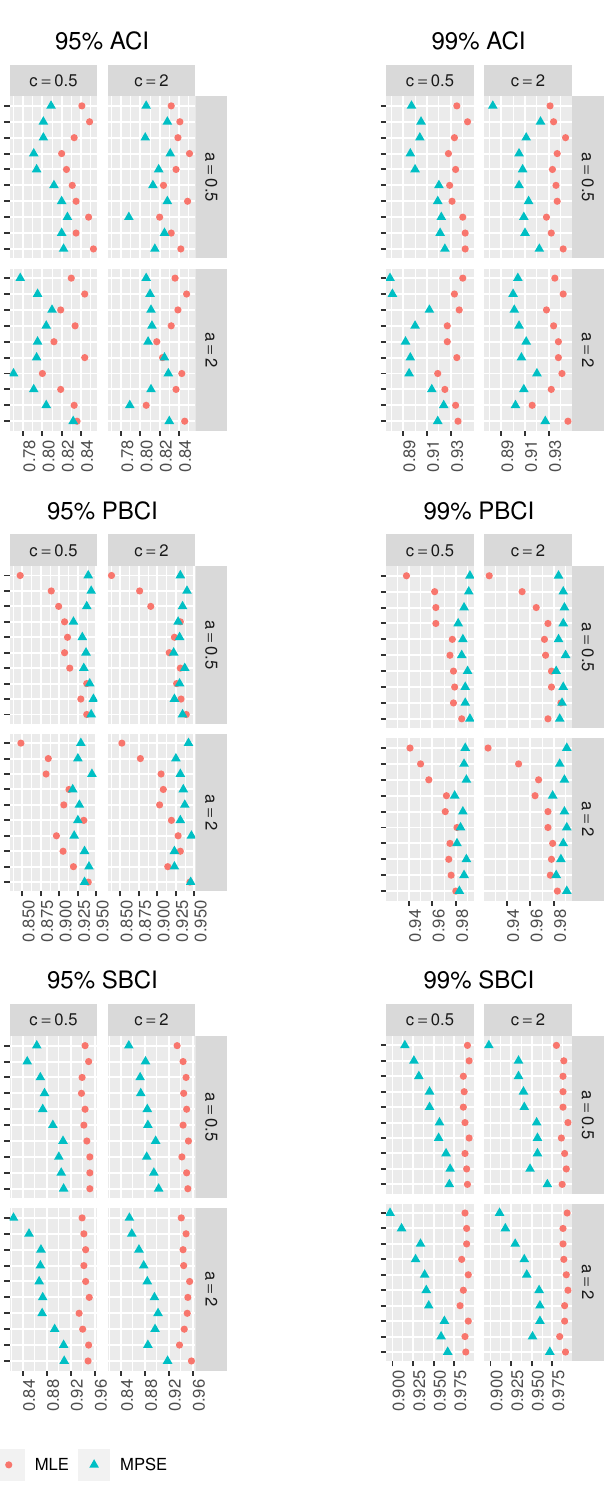
Figure 8. Simulated CPr of different CIs of a